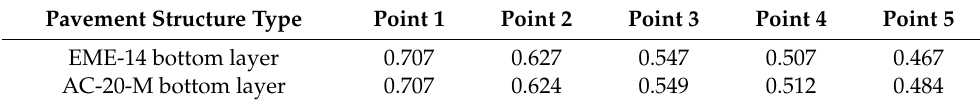
Table 13. Calculated compressive stress at the top of different layers. Pavement Structure Type Point 1